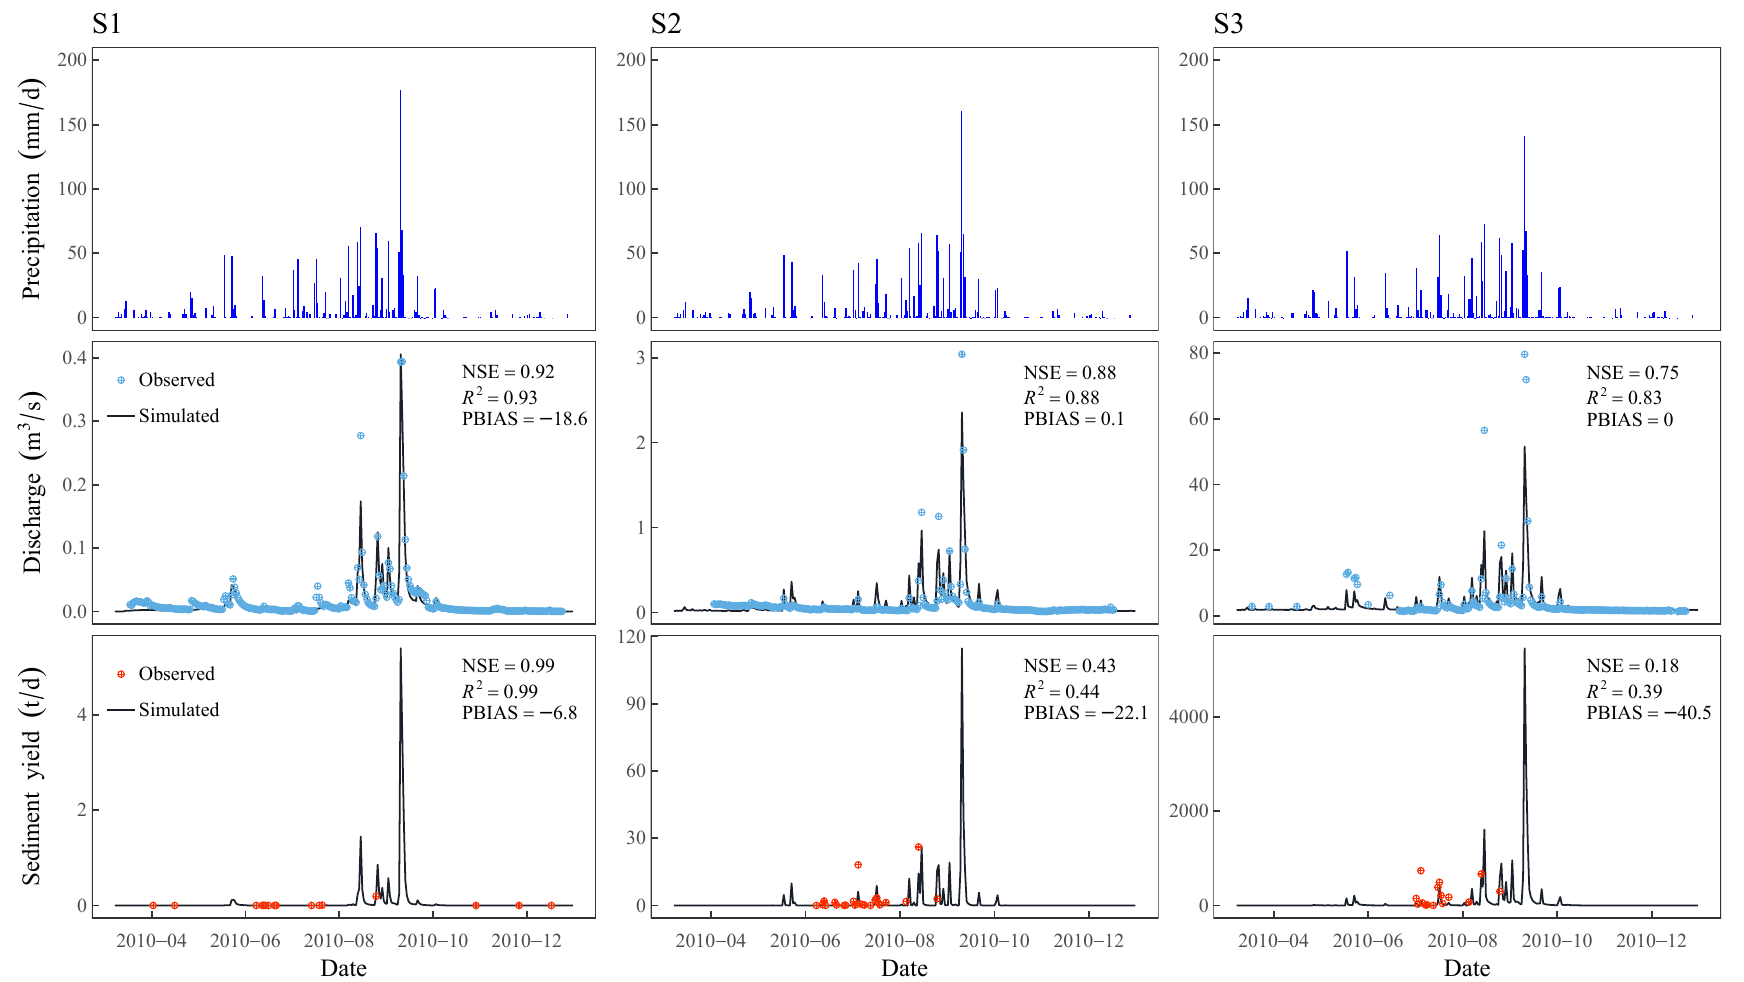
Figure 6. Calibration (S1 and S2) and validation (S3) result for stream discharge, and suspended sediment measured at the outlet of each